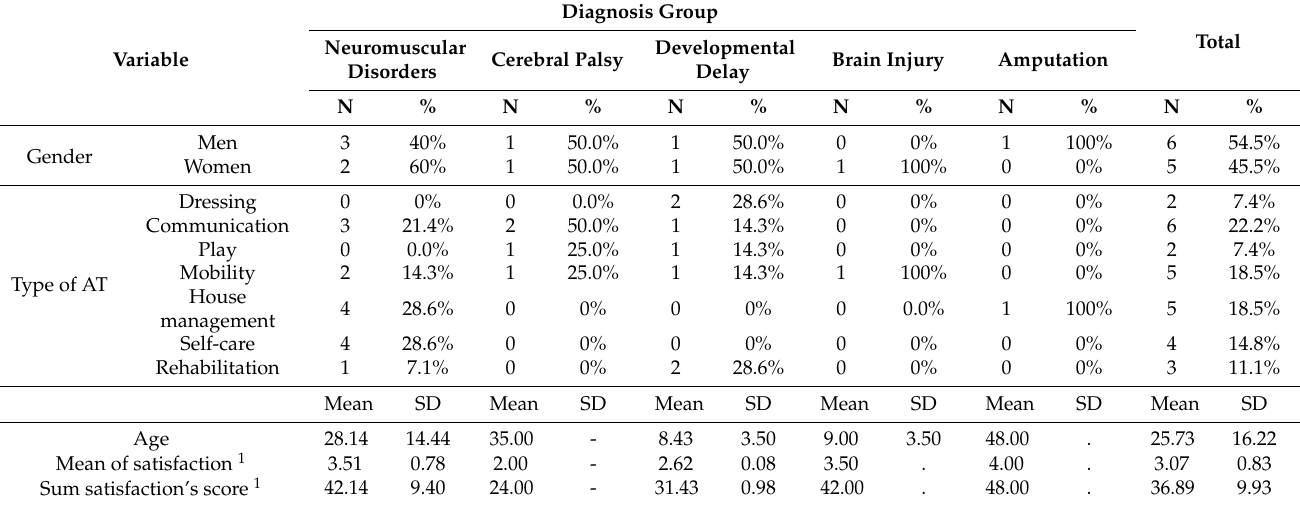
Table 2. Sociodemographic characteristics of the sample.